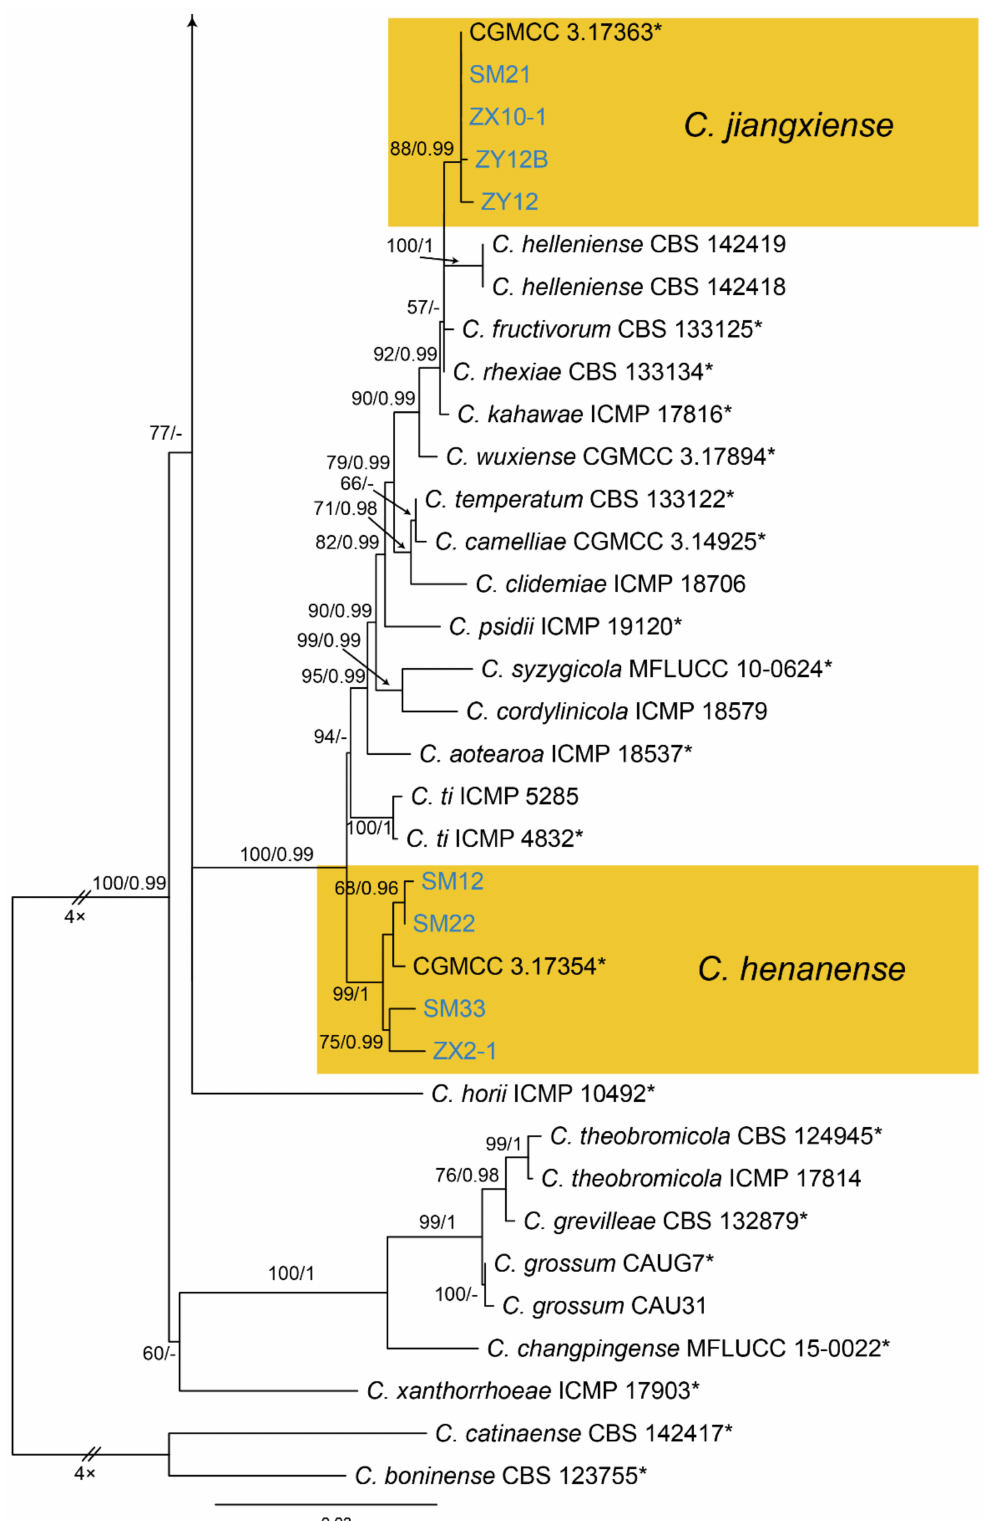
Figure A13. Phylogram generated from RAxML analysis based on combined ITS, act , chs-1 , gapdh and tub2 sequence data of Collectrichum gloeosporiodes species complex isolates. The tree was rooted to Collectrichum catinaense (CBS 142417) and C. boninense (CBS 123755). The scale bar indicates 0.03 nucleotide changes per site. Isolates from this study are marked in blue, ex-type strains are marked with *, and the identified species are marked in